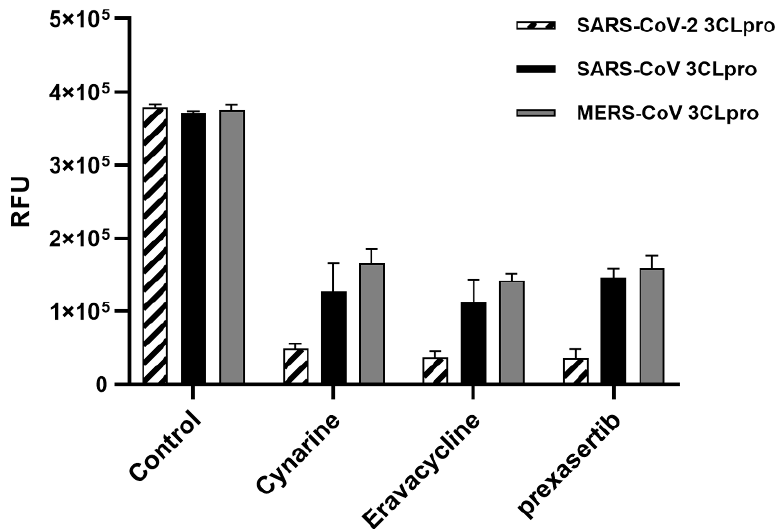
Figure 2. Inhibition of three 3CL proteases . Each column represents the effect of each inhibitory compound against SARS-CoV-2 (left), SARS-CoV (middle), and MERS-CoV (right) 3CLpros com- pared with the control. All chemicals (20 μ M) were confirmed for their inhibitory potential through a comparison of actual absorbance with the control at 490 nm. Data is expressed as the mean ± standard error of the mean ( n = 3). RFU = relative fluorescence units.